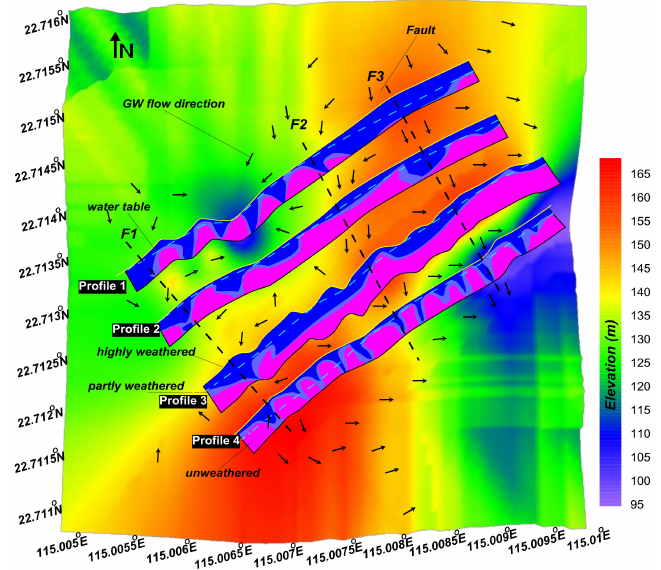
Figure 17. Interpreted ERT profiles with GW flow direction and faults orientation in the study